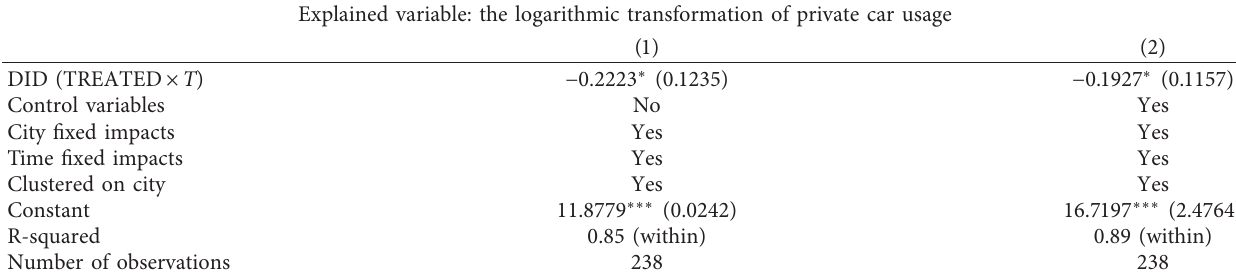
Table 8: Robustness test based on PSM-DID.